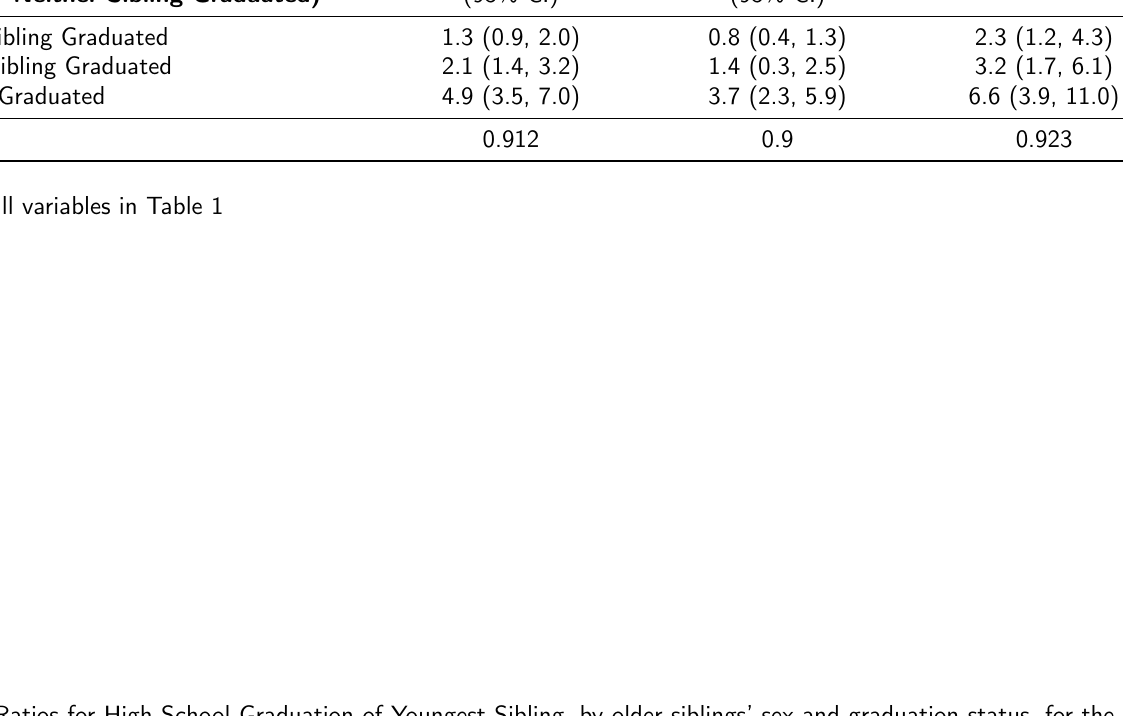
Table 3: Odds Ratios for High School Graduation of Youngest Sibling, by older siblings’ sex and graduation status, for the whole population, and males and females